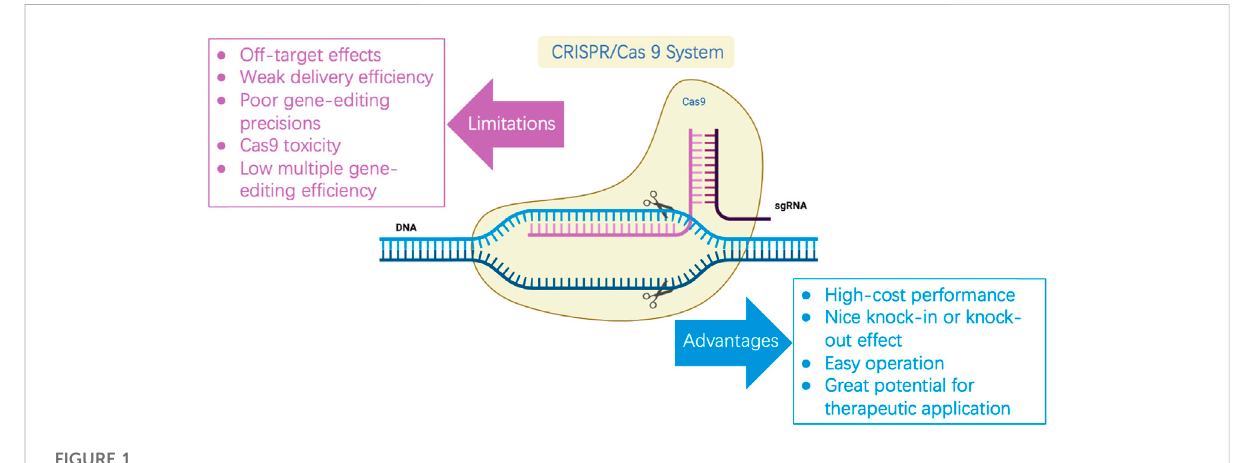
FIGURE 1 Limitations and advantages of